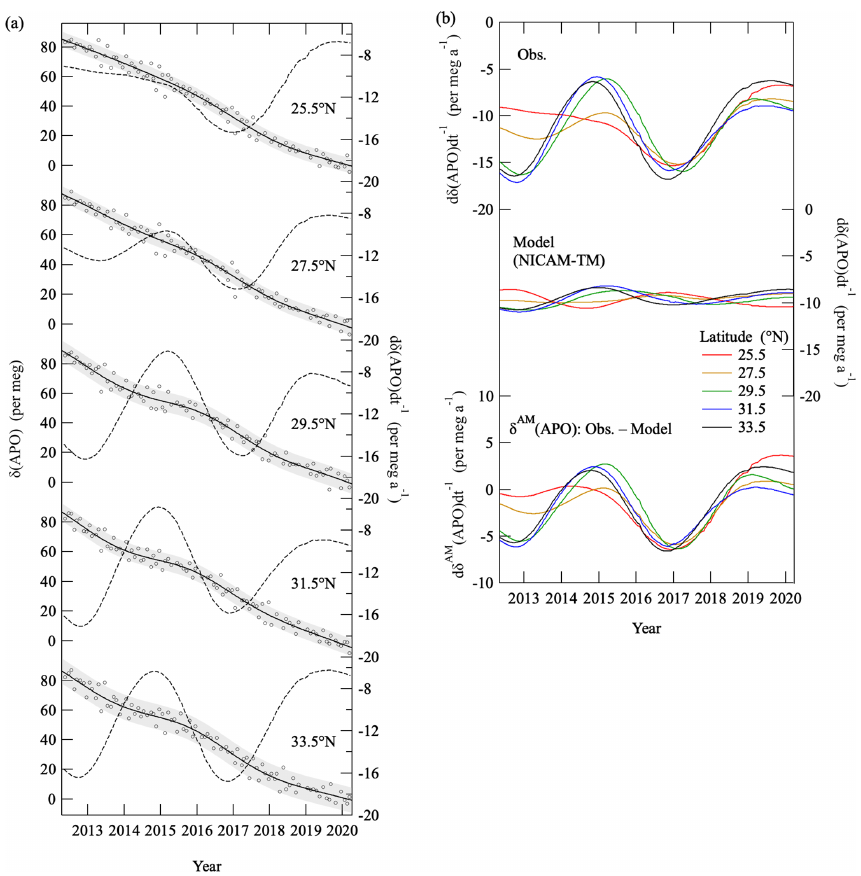
Figure 10. (a) Same secular trends in Fig. 4a and their annual change rates along with the deseasonalized values of δ (APO) at each latitude over the western North Pacific. Error bands (shaded) indicate standard deviations of the deseasonalized δ (APO) from the secular trends ( ± 1 σ ). (b) Same annual change rates in panel (a) . The corresponding change rates for the APO obtained from the control run of NICAM- TM (middle) and those of δ AM (APO) obtained by subtracting the calculated δ (APO) from the observed δ (APO) (bottom) are also